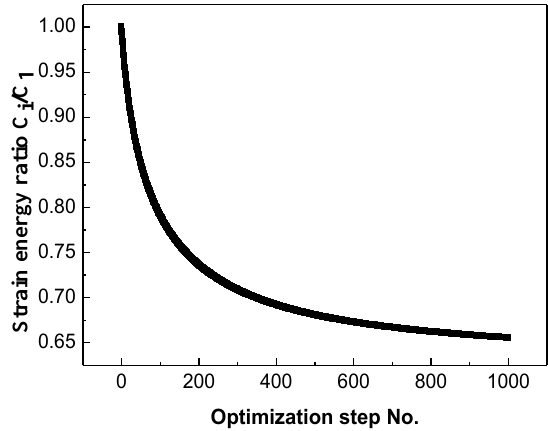
Figure 12. The convergence process of Model 2.